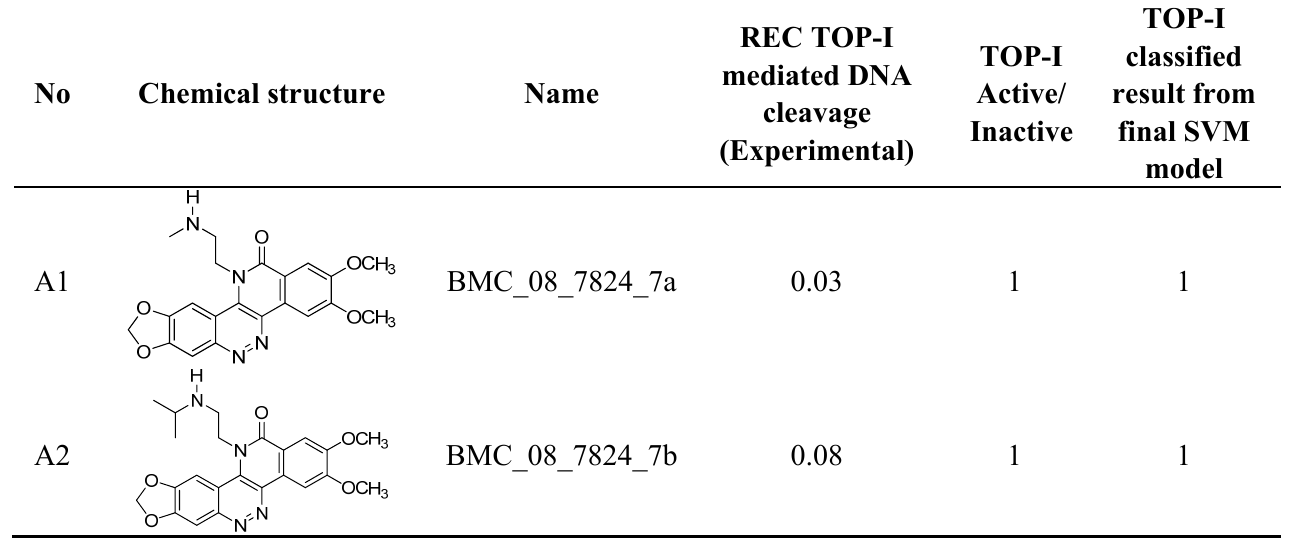
Table 5. Chemical structure of ten benzo[ c ]phenanthridine derivatives in application set and their topoisomerase I inhibitory activity REC and classification results from final SVM model. Classification term: “1” presented TOP-I active compound having equal or stronger activity than that of topotecan; “0” presented TOP-I inactive compound having weaker activity than that of